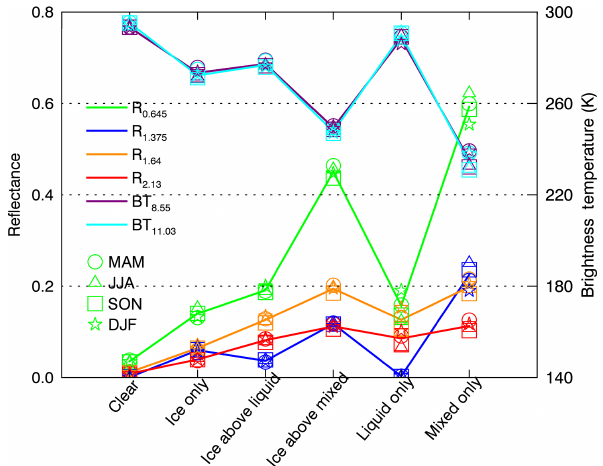
Figure 9. Average reflectance and brightness temperatures over ocean for clear sky and the five cloud groups, including all solar zenith angles. The sold lines represent annual mean, and symbols denote seasonal